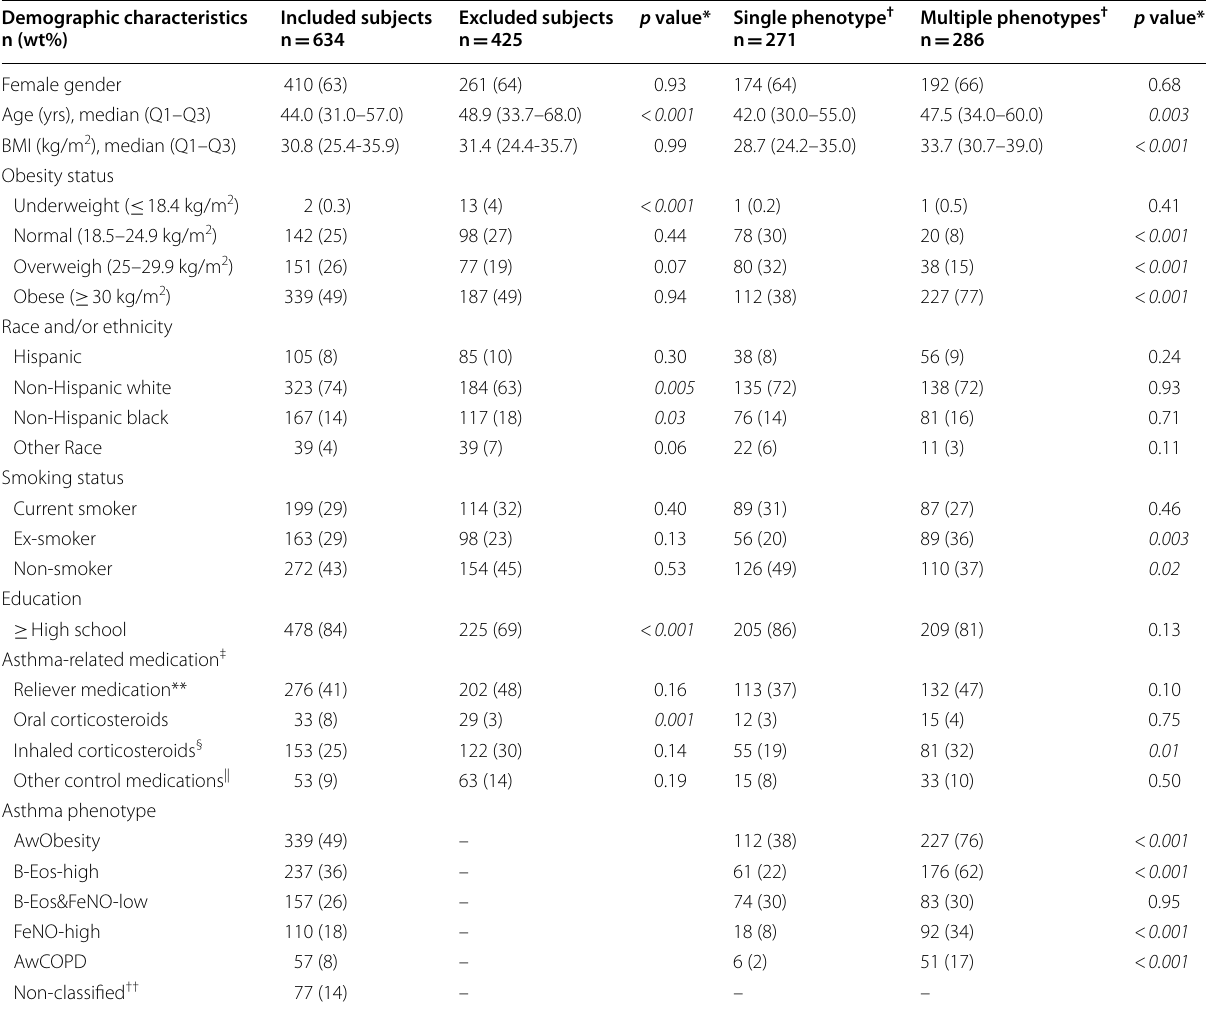
Table 1 Characteristics of adults with current asthma: included and excluded from phenotype classification, and strati- fied by single or multiple